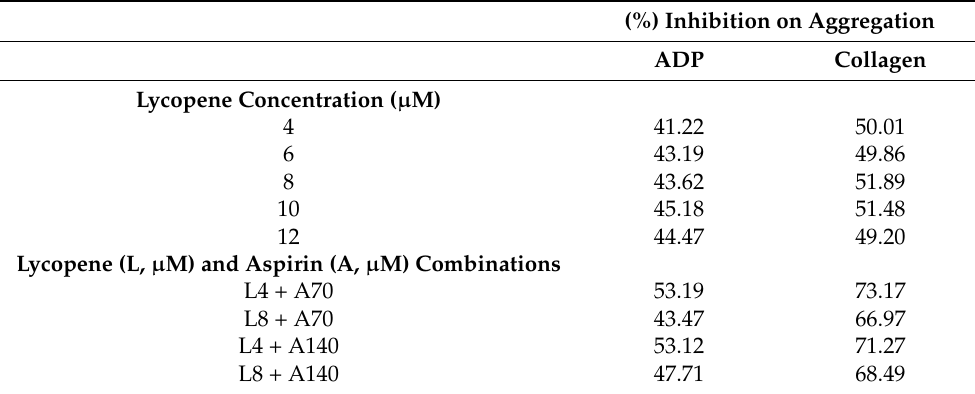
Table 4. Inhibitory effects of lycopene and its combination with aspirin on ADP- and collagen- stimulated platelets